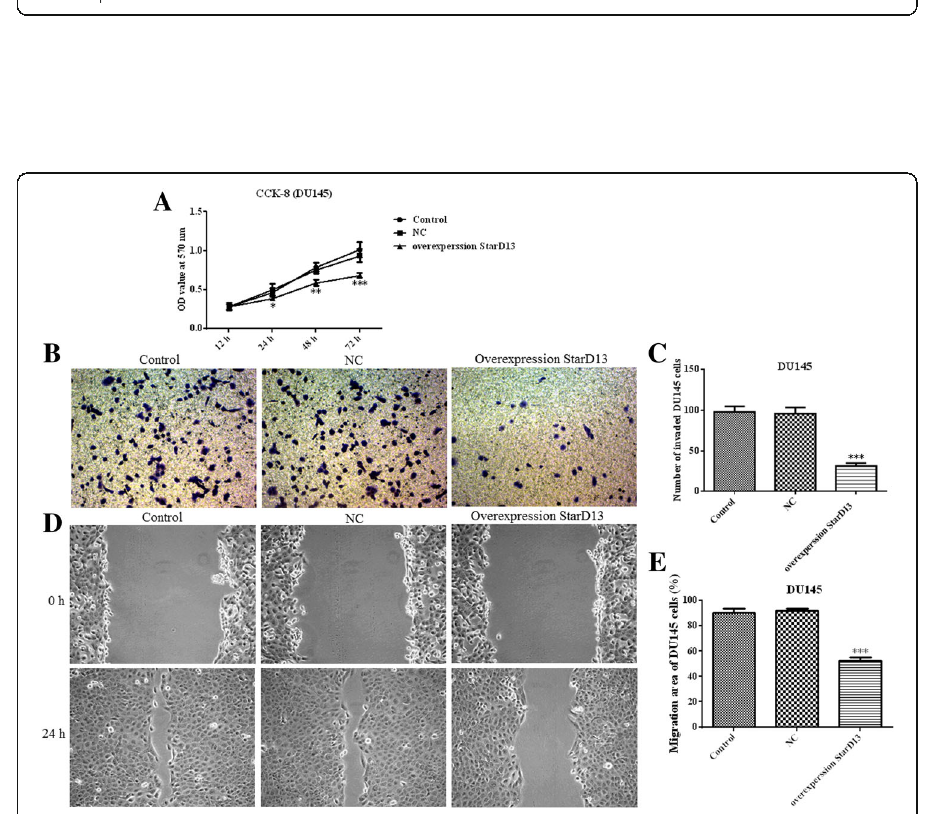
Fig. 7 Cell proliferation, invasion and migration in DU145 cells transfected with the pcDNA3.1 plasmid of StarD13. a CCK8 assay results. b through c - Transwell invasion assay results. d through e - Wound-healing assay results. ** p < 0.01; *** p < 0.001 vs. NC group. All experiments were performed with at